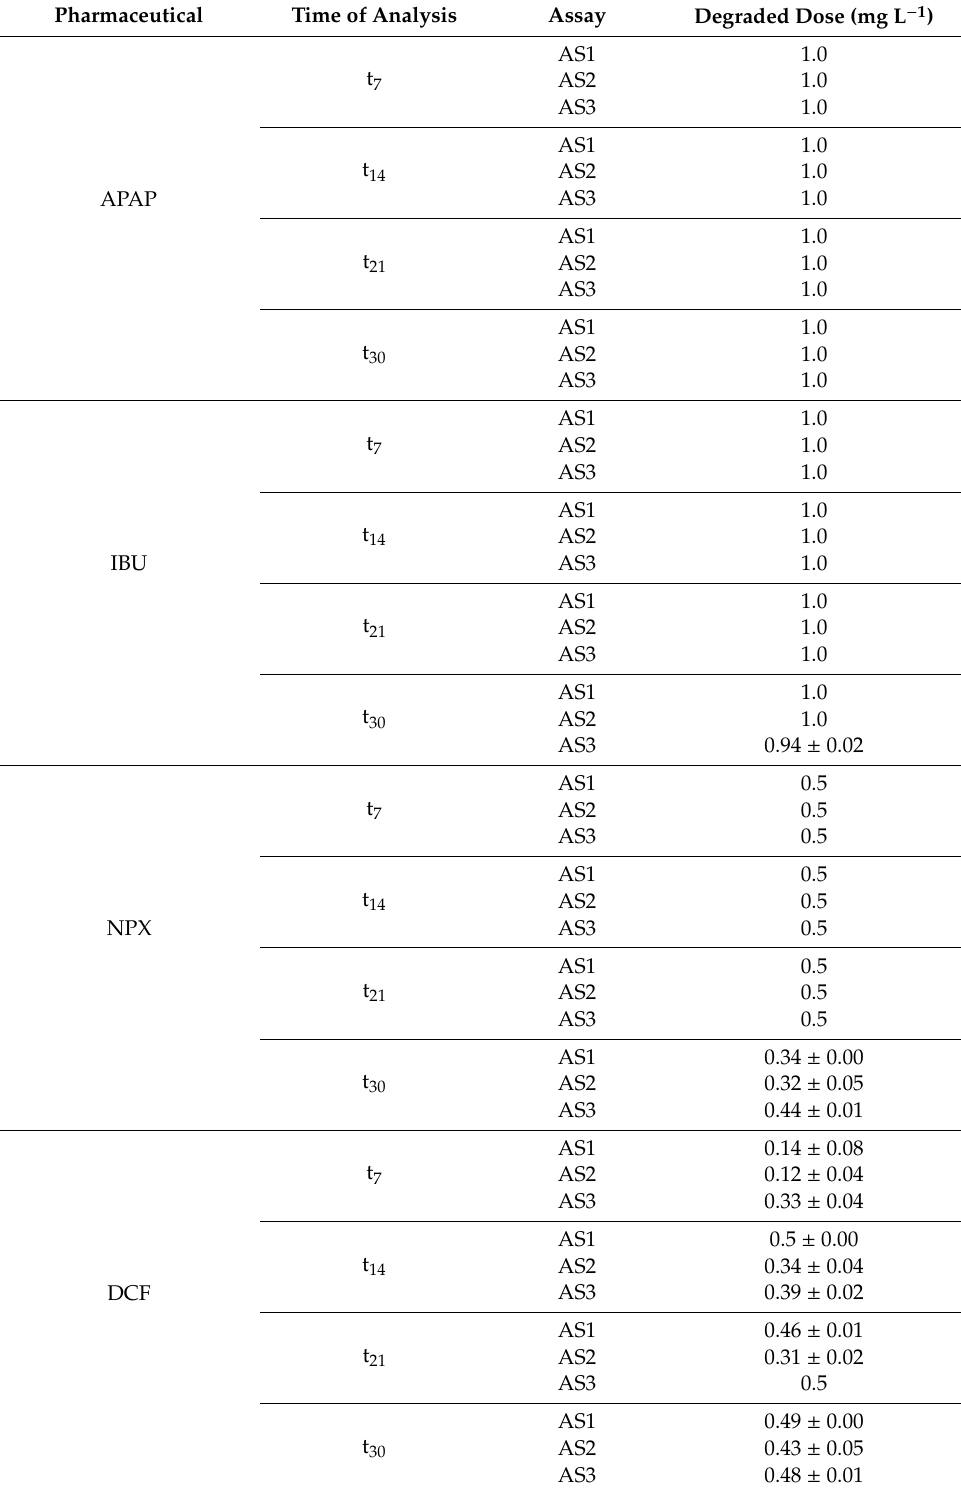
Table 5. Degraded doses of analyzed pharmaceuticals in the AS1, AS2, and AS3 assays during 30 days of